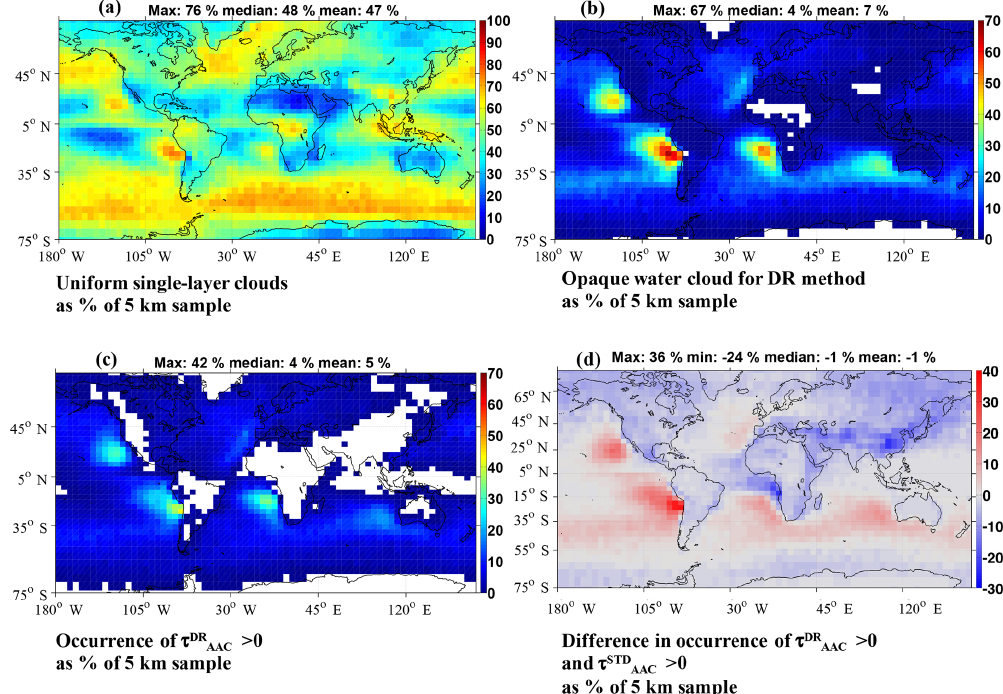
Figure 1. During nighttime, from 2008 to 2012 on a 4 ◦ × 5 ◦ grid: occurrence frequencies of (a) uniform single-layer clouds (C1–C3 of Table B2), (b) opaque water clouds suitable for the DR method (C1–C5 of Table B2; these clouds can be obstructed or unobstructed) and (c) AAC cases that show a positive τ DR at 532nm. Panel (d) shows the difference between the number of AAC cases using the DR method AAC > 0) and the number of AAC cases using the standard Version 3 CALIOP product (i.e., number of cases (i.e., number of cases with τ DR AAC > 0); CALIOP AAC cases using the standard algorithm are defined as 5km columns showing an uppermost layer classified as with τ STD AAC aerosols and a cloud layer anywhere below that aerosol layer; the cloud itself does not have to satisfy any of the criteria of Table B2. Grid cells are 4 ◦ × 5 ◦ latitude–longitude. The percentages in (a) – (d) use the number of 5km CALIOP samples within each grid cell as a reference. White pixels show either no CALIOP observations, no CALIOP OWC detection, a small number of CALIOP unobstructed OWCs or a small number of positive τ DR values. The title of each map shows the global maximum, median and mean AAC